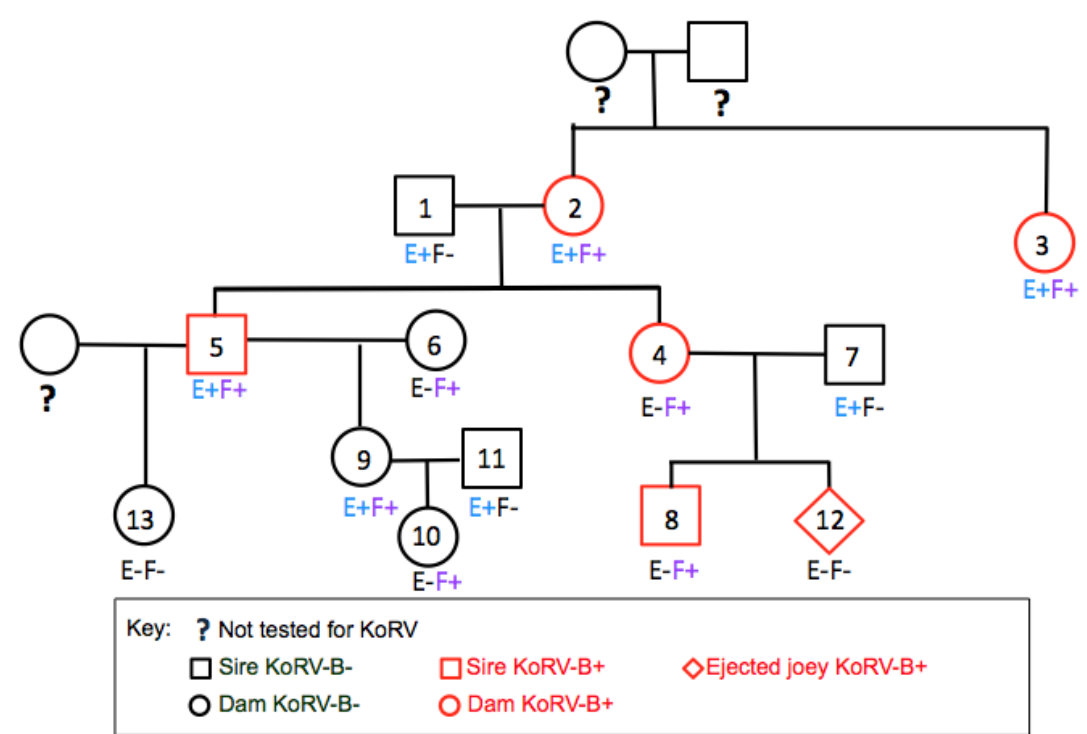
Figure 5. KoRV-E and KoRV-F are not vertically transmitted. All koalas are KoRV-A positive. Male and female koalas are denoted as square and circle symbols, respectively, in the family tree. KoRV-E positive koalas are denoted as E+ and KoRV-F positive koalas as F+ . 3.5. Defective KoRV-B, -E and -F Were Detected in Koalas Containing Intact KoRV-B Virus or KoRV-E and -F